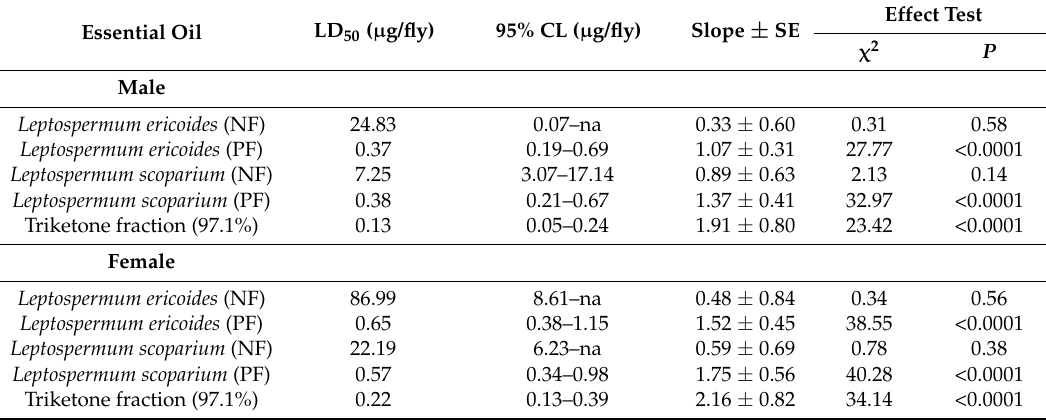
Table 4. LD 50 values for the non-polar and polar chromatographic fractions of L. ericoides and L. scoparium and the triketone fraction of L. scoparium against